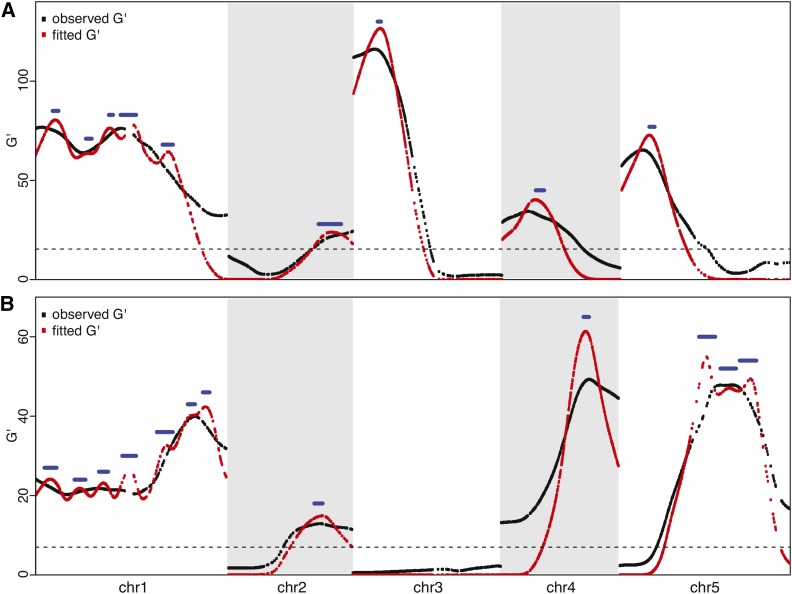
Mapping results using target-enriched extreme QTL. (A) Quantitative trait locus (QTL) map of Arabidopsis thaliana seedling greening in response to salt. (B) QTL map of Arabidopsis thaliana seed size. Black dots are observed G′ values of markers from three replicated experiments combined. The smoothing window of 36cM was used. Red dots are fitted G′ values based on the model-selection method. Blue bars show the support intervals of QTL peaks with 95% confidence. Dashed horizontal line shows the 1% false-discovery rate threshold of G′ values.